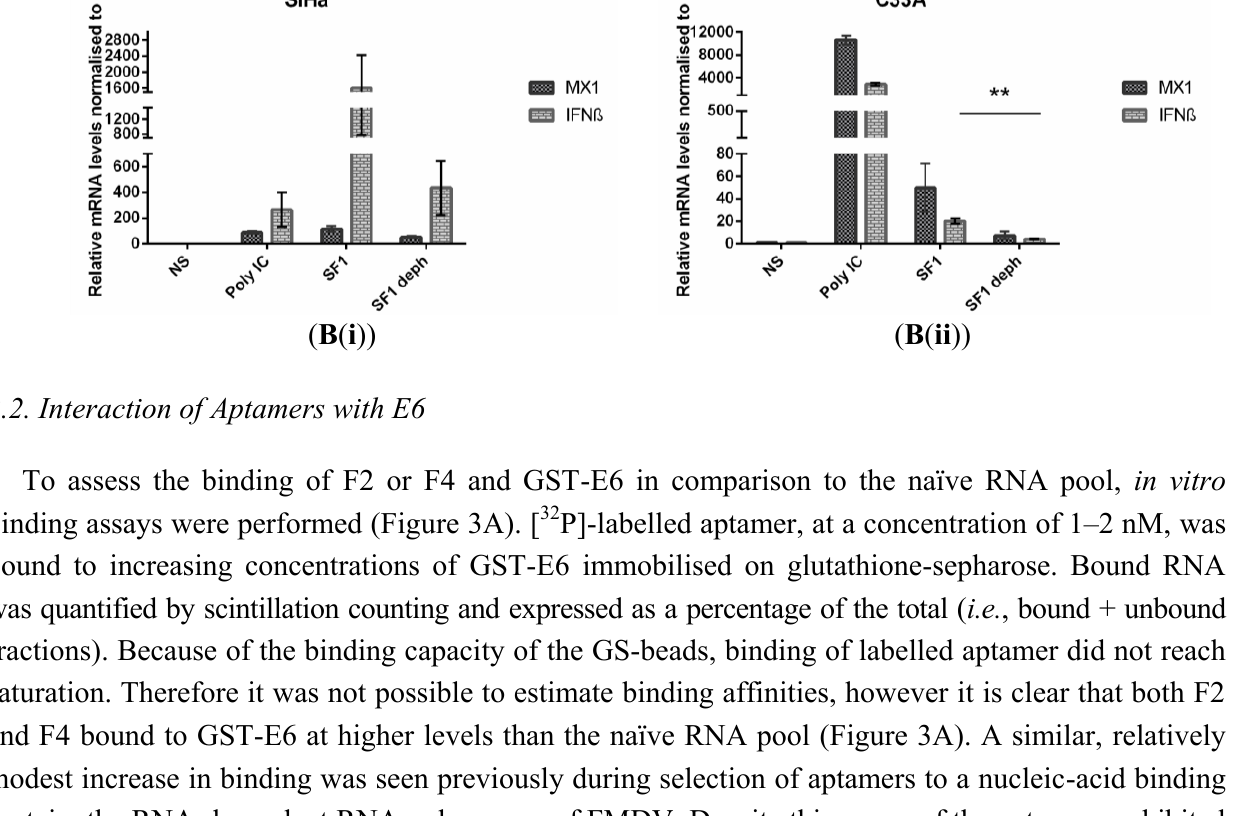
Figure 3. Binding of aptamers F2 and F4 and the naïve pool (N) to E6. ( A